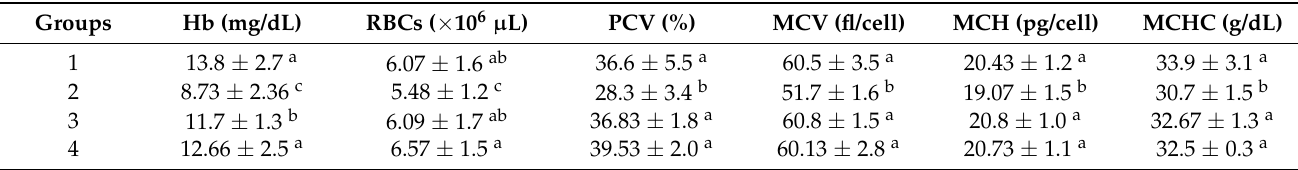
Table 2. Hematological indices in lead-acetate-induced anemic rats treated with chemical or green biosynthesized magnetic iron oxide nanoparticles. Groups